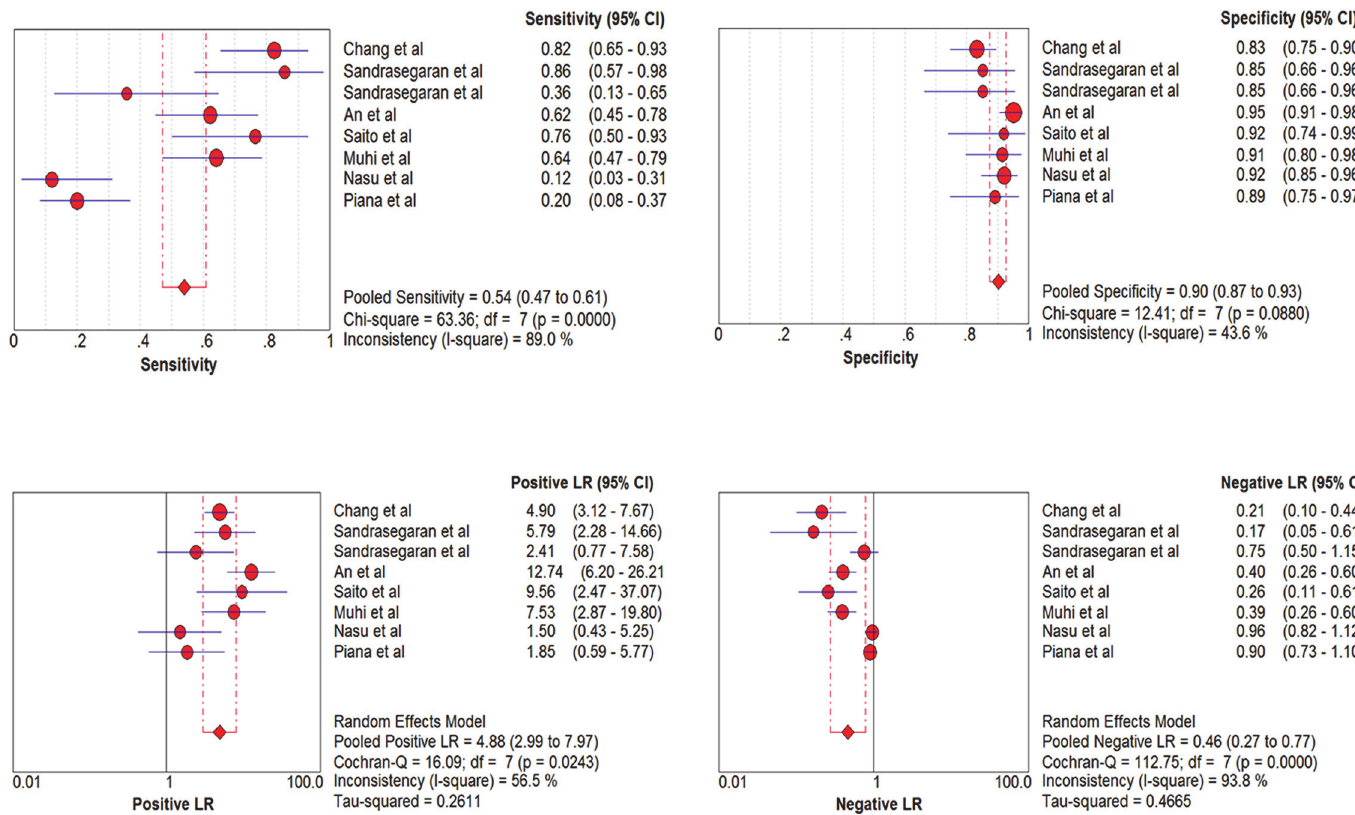
Fig 3. Forest plots of the estimates for DWI in predicting w-HCC. The Q statistics and I 2 indexes of specificity suggested the presence of notable heterogeneity, and the diagnostic performance was summarized by using a random-effects coefficient binary regression